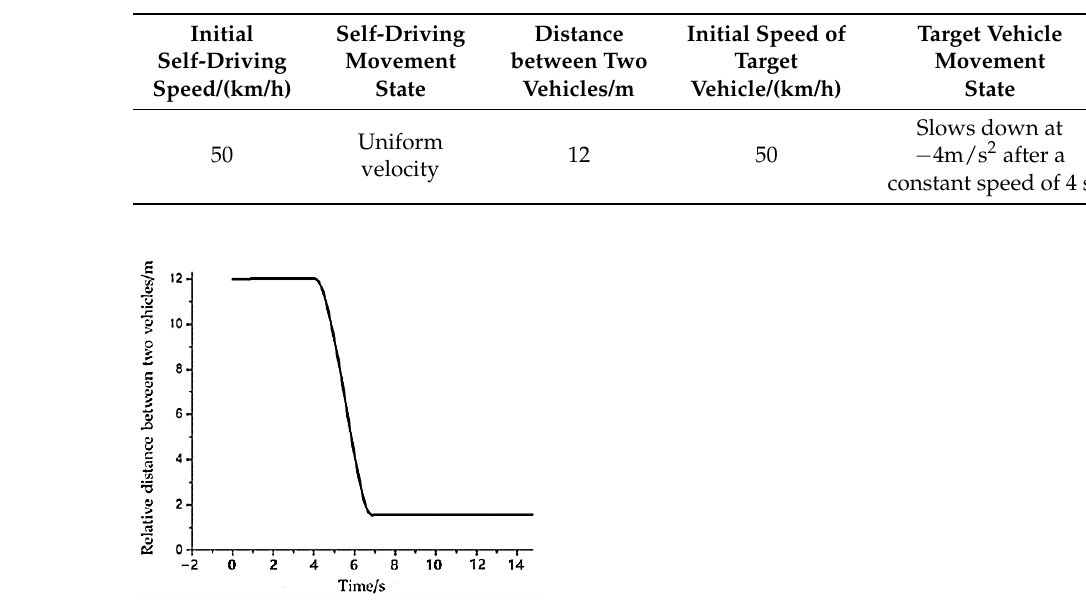
Figure 12. Relative distance between two vehicles in CCRb test.